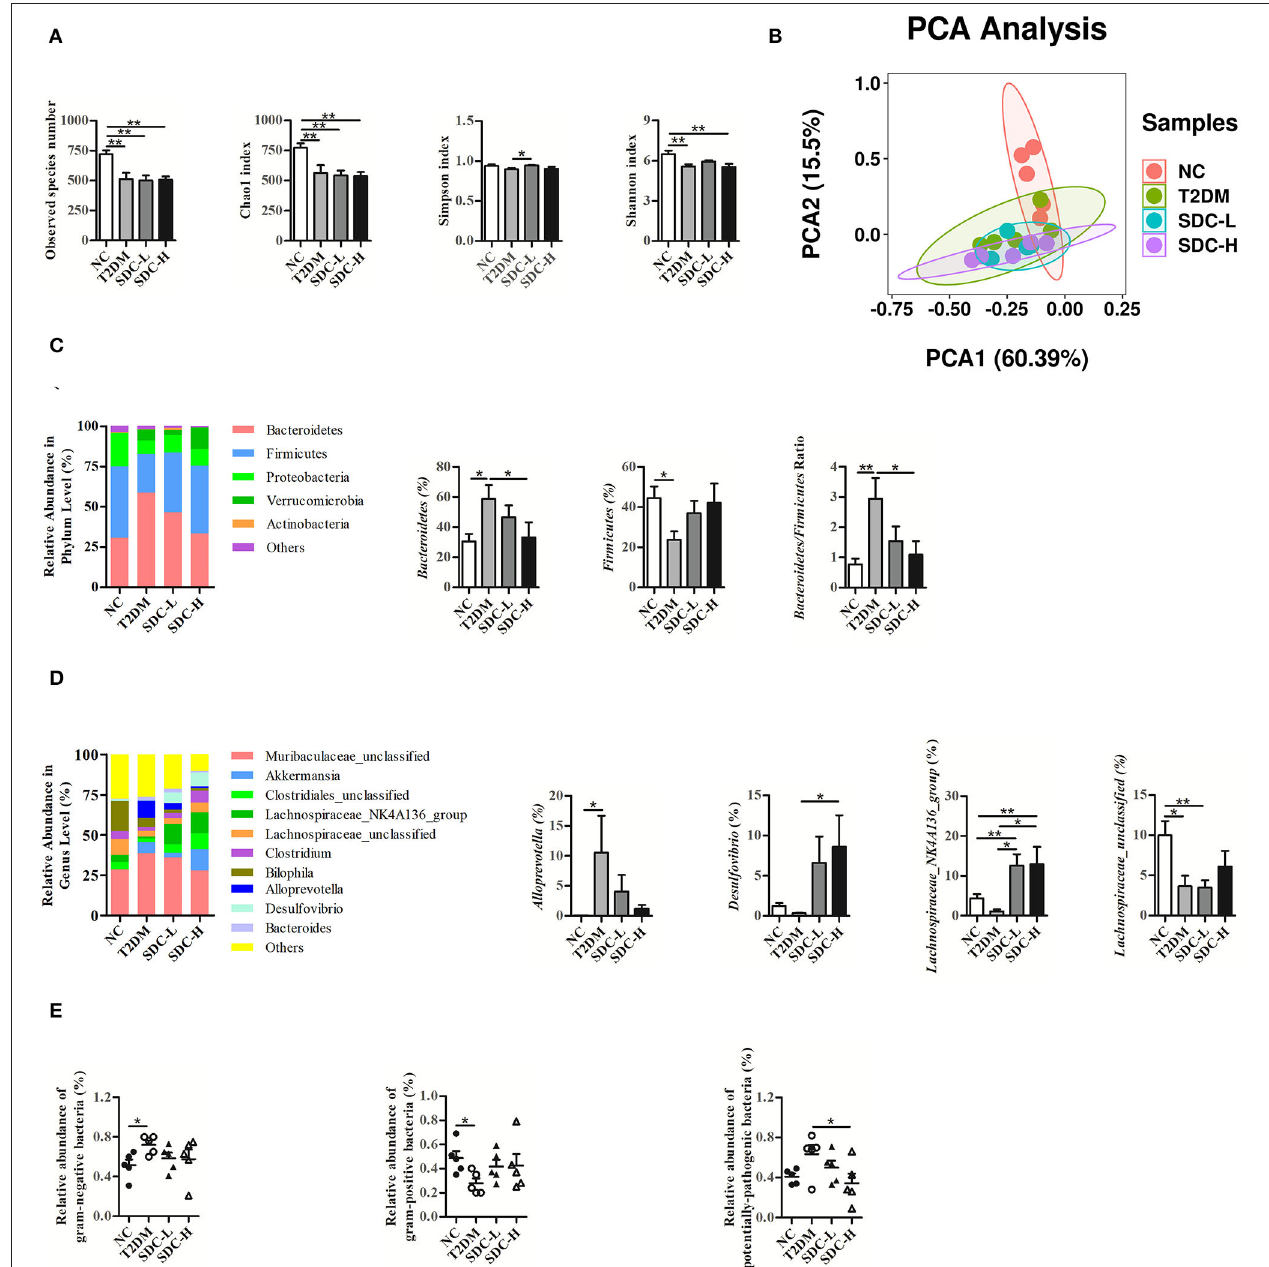
FIGURE 6 | Alpha diversity (A) and beta diversity (B) of the mice; Change in phylum (C) and genus (D) with different treatments; The prediction of bacterial phenotypes in different groups (E) . n = 5, * P < 0.05, ** P < 0.01. liver and skeletal muscle, respectively. The inactivation of GLUT- 2 in the liver may lead to impaired glucose-stimulated insulin secretion (41). Impaired expression of GLUT-4 was linked to obesity, type 1 diabetes, and type 2 diabetes (42). In the present study, intervention with SDC increased liver GLUT-2 levels and skeletal muscle GLUT-4 levels in high-fat diet/streptozocin- induced T2DM mice, suggesting that SDC may regulate glucose metabolism through the regulation of GLUT-2 and